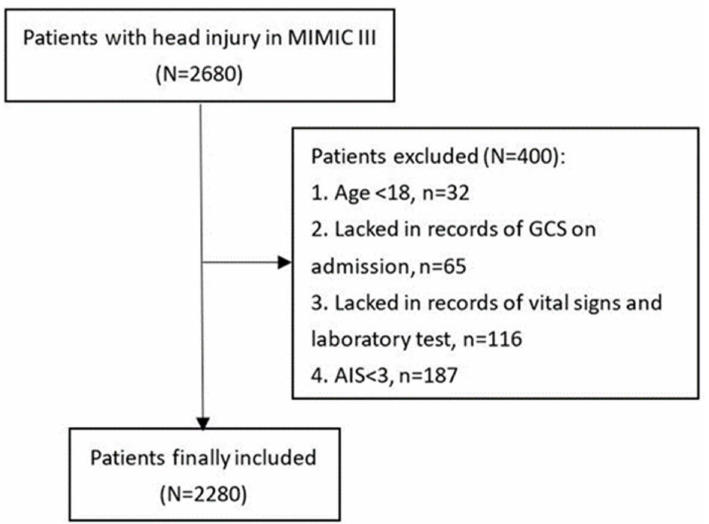
Figure 1. Flowchart of patients inclusion. Medical Information Mart for Intensive Care—III (MIMIC-III), Glasgow Coma Scale